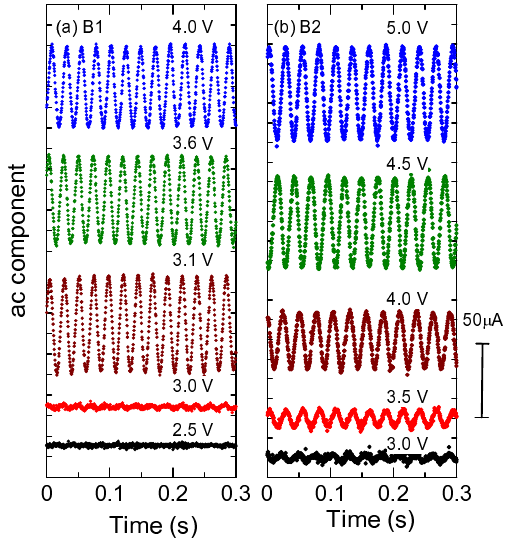
Figure 2 . The current oscillation in various constant voltages ( V (b) Sample B2. The standard resistance is 1 k Ω , and the temperature is 4.3 K. Sample